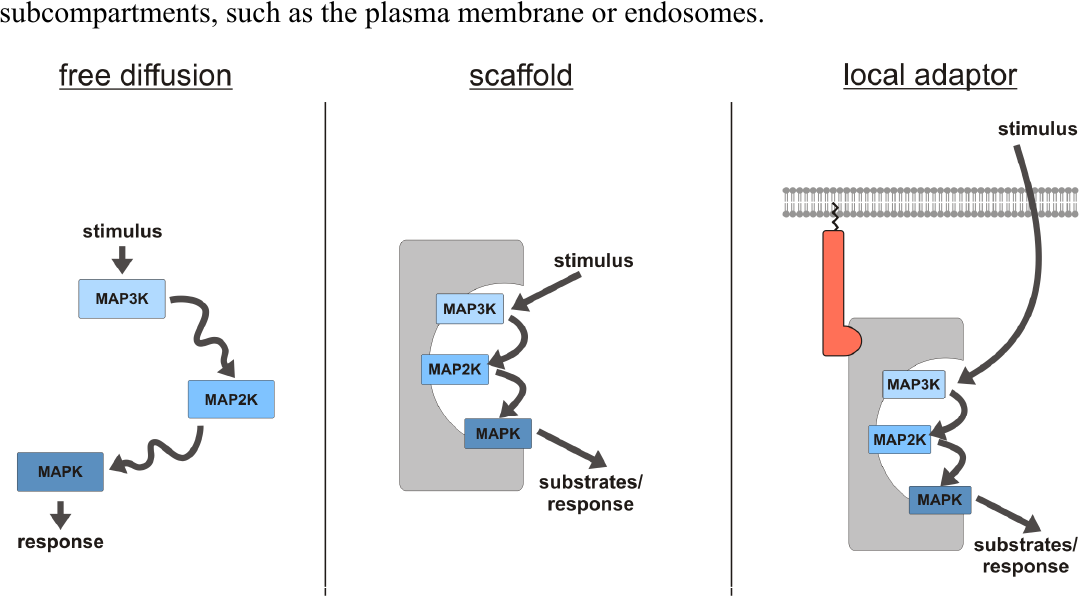
Figure 2. Characteristics of scaffolding proteins. ( left ) The model postulating a